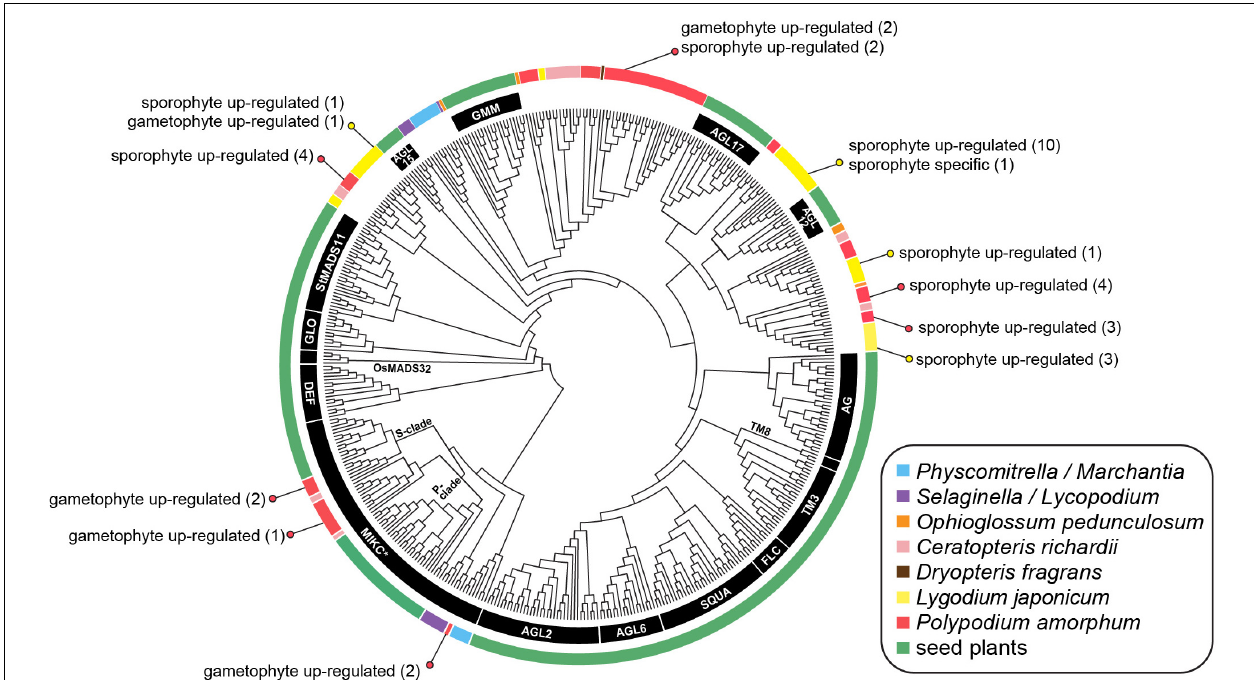
FIGURE 8 | Cladogram of the best maximum likelihood tree of land plant Type II MADS-box sequences. Specific MADS-box genes, as described by Kwantes et al. (2011) and Gramzow and Theissen (2013), are indicated by black lines or along branches. Colored lines indicate the taxonomic identity of particular sequences (see inset legend). Colored dots and text describes the number of transcripts that are phase-specific or phase up-regulated in the ferns Polypodium amorphum (red) and Lygodium japonicum (yellow). Node support values are provided at Figshare (doi: